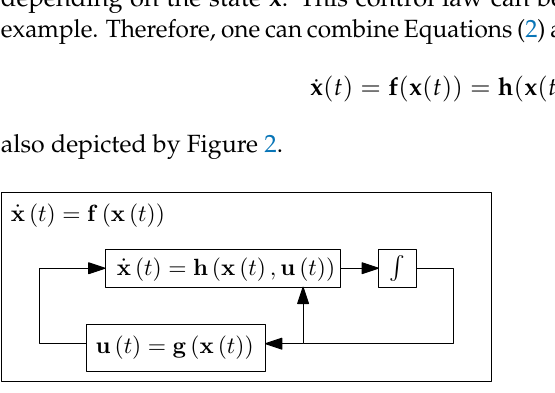
Figure 2. A robot and its controller can be modeled as a dynamical